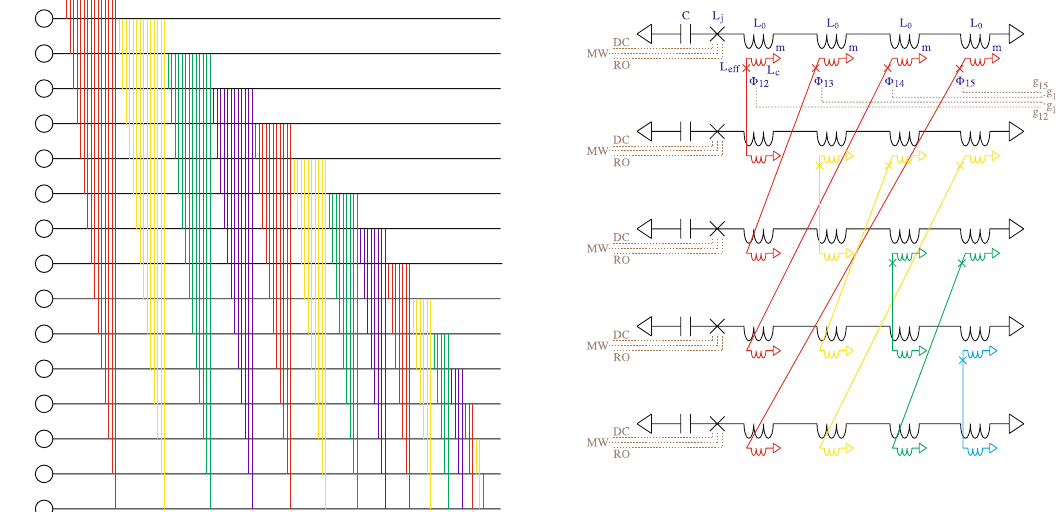
Figure 2. Possible layout for an SES chip. On the left, the circles represent qubits, the horizontal lines are wires, and the colored vertical lines are couplers. This is shown in more detail on the right for n = 5 . Each horizontal circuit is a superconducting qubit with capacitance C , tunable junction inductance L j , and n − 1 additional coils (each with self-inductance L 0 and mutual inductance m ) for coupling to other qubits. Brown dotted lines indicate dc and microwave control lines for each qubit, as well as readout circuits. Each colored coupler wire contains a Josephson junction with inductance L c tuned by a magnetic flux (cid:31) . Control lines for some off- diagonal SES Hamiltonian matrix elements are also indicated in